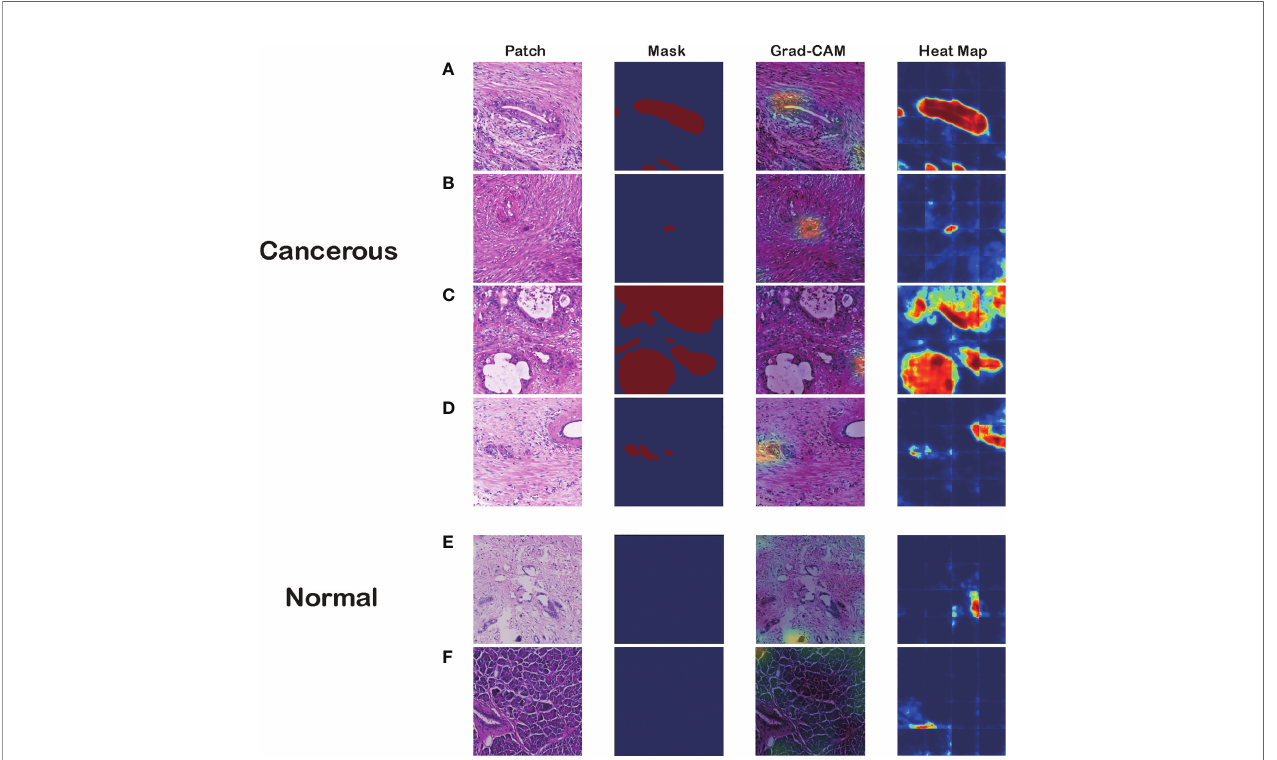
FIGURE 4 | Visualizations of different pancreatic lesions by Grad-CAM and the corresponding heatmaps. (A – D) Positive sets with cancerous tissues. (E, F) Negative sets with background or normal tissue. The four columns from left to right are patch extracted from WSIs, mask generated from the annotation, Grad-CAM and heatmap presentation for these patches,